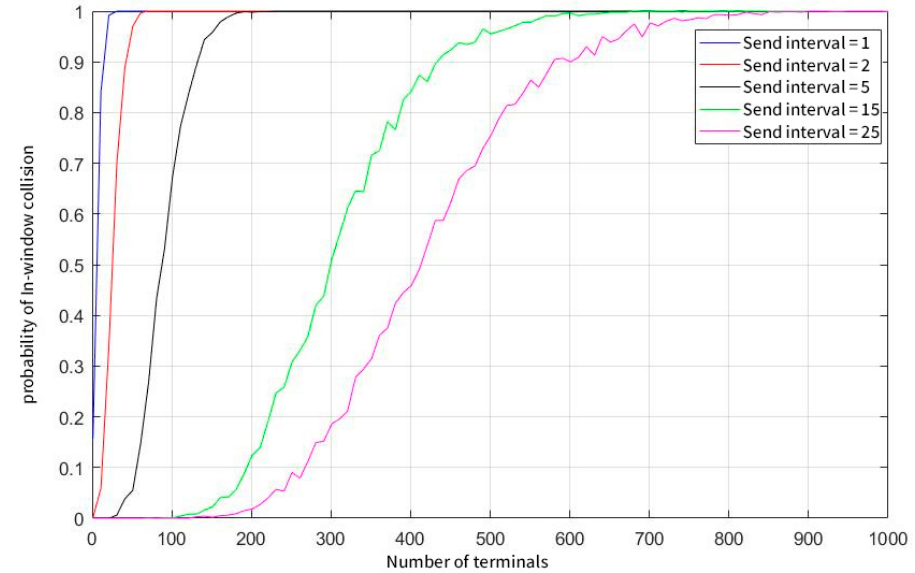
Figure 6. The probability of a window collision at concurrent demodulation thresholds equals 10.